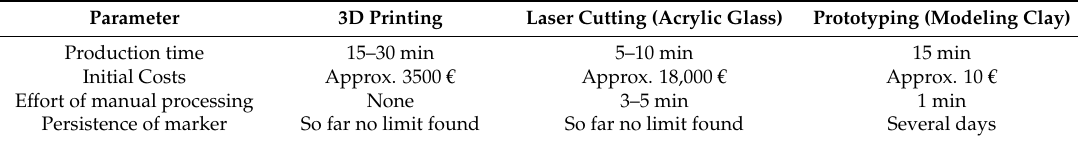
Table 2. Tabellaric line-up of fabrication techniques characteristics.